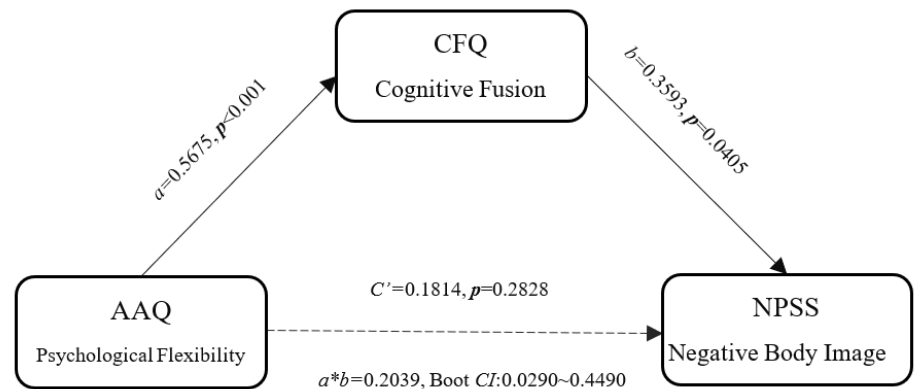
Figure 2. Model testing that the relation between Psychological flexibility (Post–Pre) and Negative body image attitude (Post–Pre) is mediated by Cognitive fusion (Post–Pre). The bias-corrected 95% bootstrap confidence interval (CI) for the indirect effect (a*b = 0.2039) based on bootstrap samples was above zero (0.0290~0.4490). The letters a, b, a*b, and c’ refer to estimated path coefficients. Standardized coefficients and their corresponding p values are presented for each path.